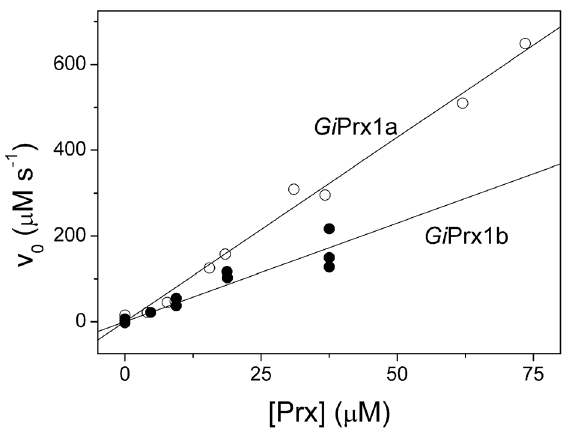
Figure 4. Initial rate of ONOO 2 decomposition by Gi Prxs. Initial rates of ONOO 2 consumption as a function of the Gi Prxs concentration. From linear regression analysis, the following second-order rate constants were determined: k , 4 6 10 5 M 2 1 s 2 1 ( Gi Prx1a) and